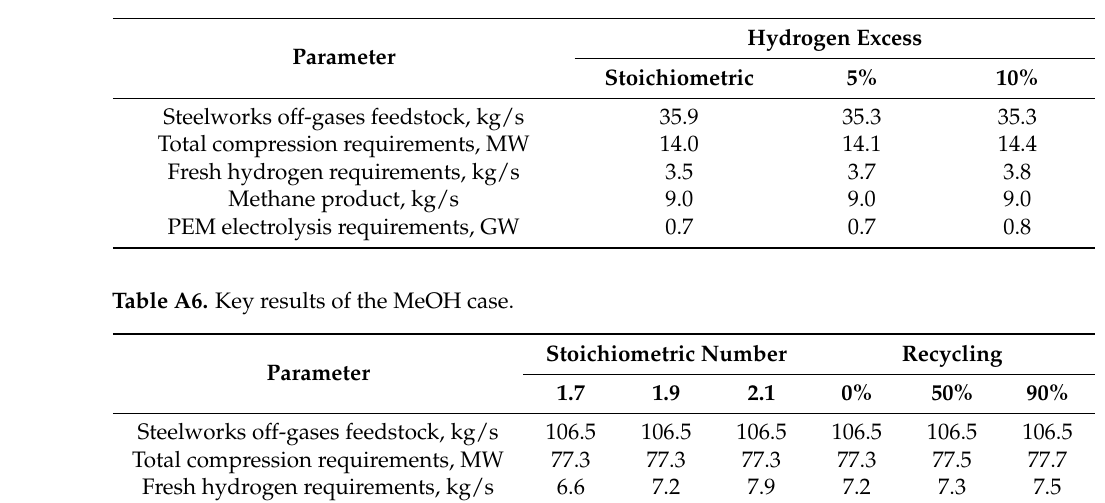
Table A5. Key results of the NG case.